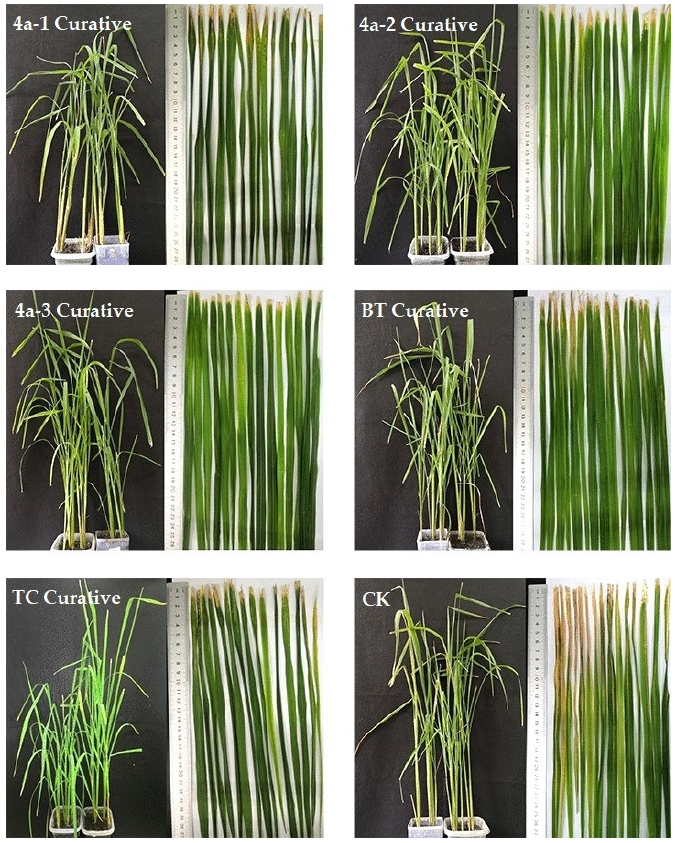
Figure 3. Curative activity of compounds against Xanthomonas oryzae pv. oryzae under greenhouse Figure3. Curativeactivityofcompoundsagainst Xanthomonasoryzae pv. oryzae undergreenhousecondition. condition. Table 4. Curative e ff ect of compounds 4a-1 , 4a-2 and 4a-3 against Xanthomonas oryzae pv. oryzae